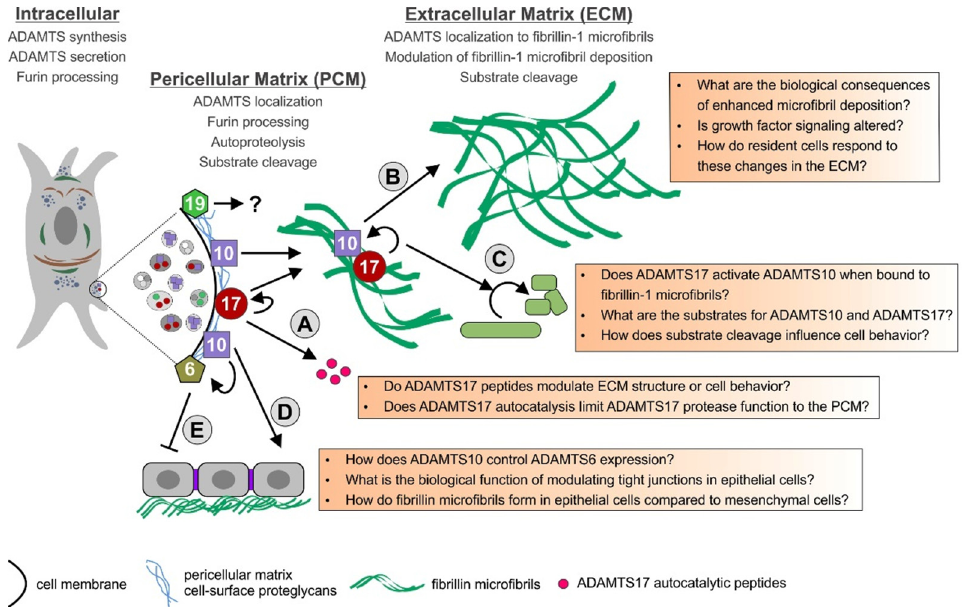
Figure 2. Model for the function of ADAMTS6, 10, 17, and 19 and their possible interactions. The ADAMTS proteases are furin-processed in the secretory pathway or at the cell surface and remain cell surface-associated or are released in the ECM. ADAMTS17 is autocatalytically processed and ADAMTS17 peptides are released from the cell surface (A). ADAMTS10 and ADAMTS17 bind to fibrillin microfibrils. ADAMTS10 can augment the deposition of fibrillin-1 microfibrils in the ECM (B). Fibrillin microfibrils could bring ADAMTS10 and ADAMTS17 together allowing ADAMTS17 to activate ADAMTS10 (C). ADAMTS10 also plays a role in regulating tight junctions and fibrillin microfibril formation in epithelial cells (D). ADAMTS10 can suppress ADAMTS6 gene expression through an unknown mechanism. When ADAMTS6 is overexpressed in epithelial cells, tight junctions, focal adhesions, and fibrillin microfibrils are disorganized (E). The role of ADAMTS19 in the PCM and ECM is currently unknown, but ADAMTS19 likely works as a true protease.